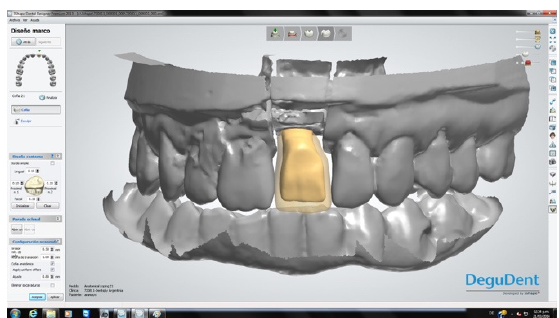
Figure 8. CAD-CAM restoration design.